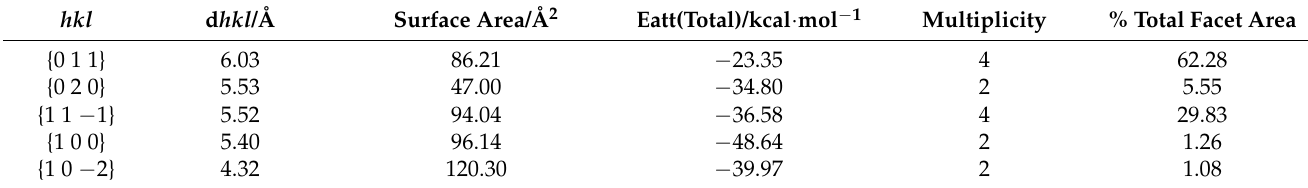
Table 2. Parameters of the main growth surface of β -HMX in a